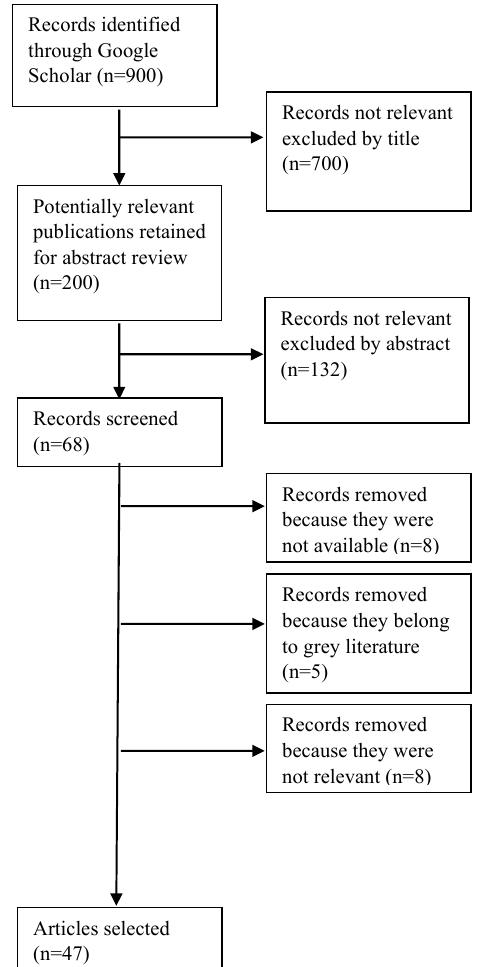
Figure 3. Flow chart of the bibliographic search.